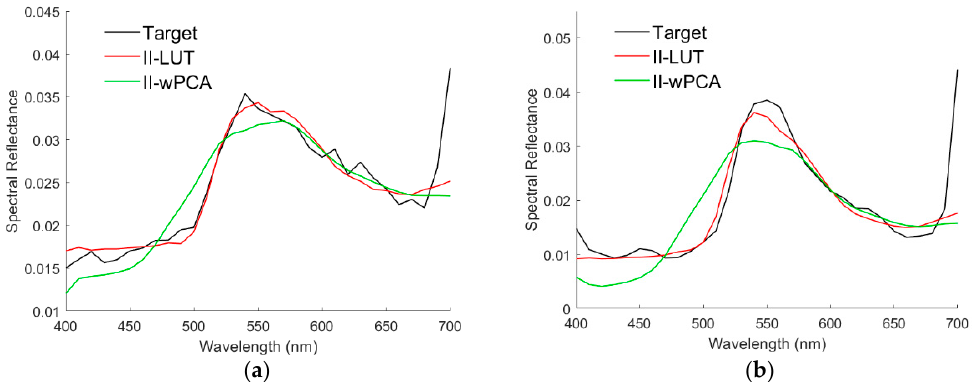
Figure 24. ( a , b ) are the Figure 23a,d, respectively, except for the black compensation using the image values of the case in Figure